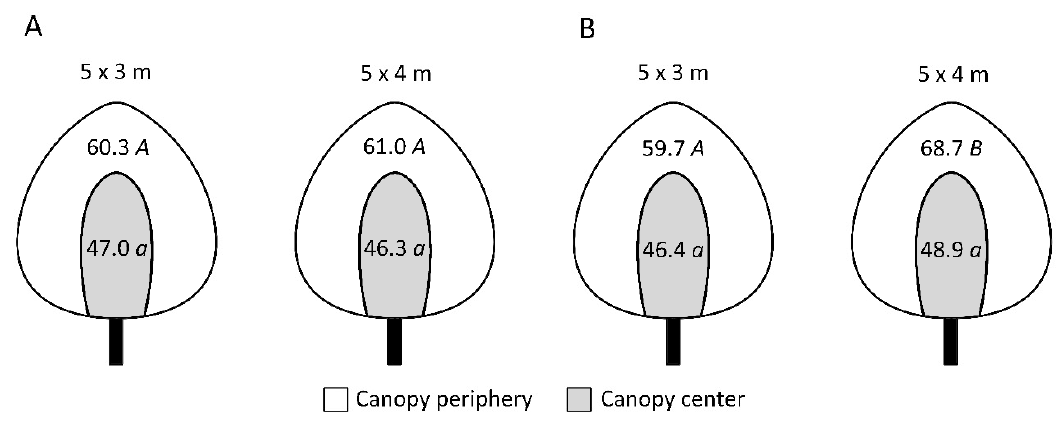
Figure 1: Light interception of central and peripheral zones of tree canopies of ‘Melitopolska chorna’ (A) and ‘Krupnoplidna’ (B) sweet cherry cultivars, % of the open area,